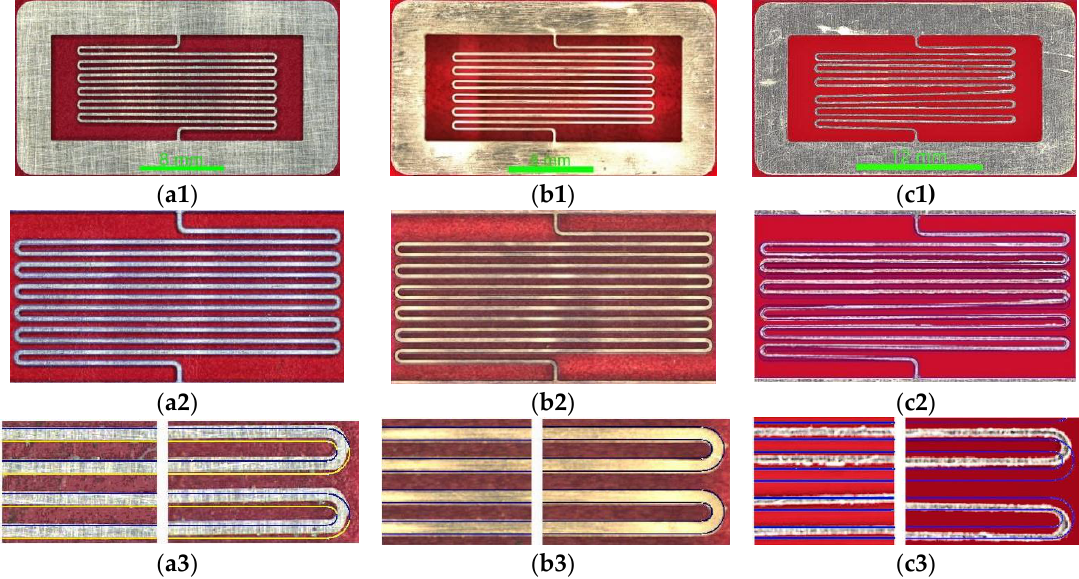
Figure 13. 0.5 scale fluxures cut with Zund, MicroMAX, and Neo at Datron (from left to right): As-cut flexures with frames ( a1 , b1 , and c1 ); tool paths superimposed onto flexure elements ( a2 , b2 , and c2 ); and tool paths superimposed onto flexure elements—zoomed in ( a3 , b3 , and c3 ).